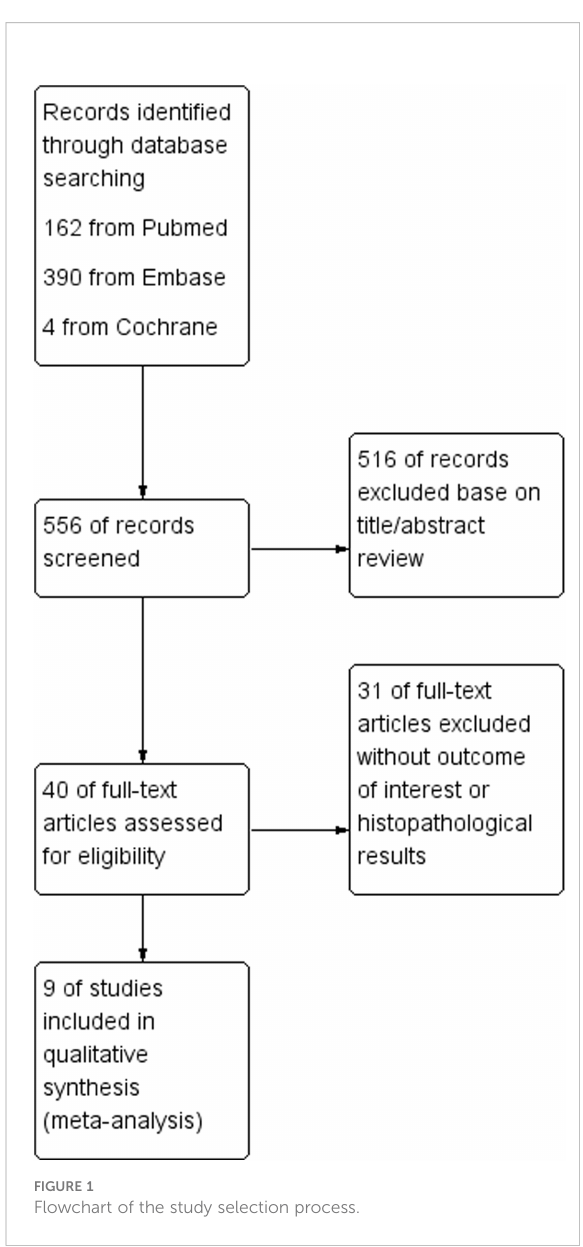
FIGURE 1 Flowchart of the study selection